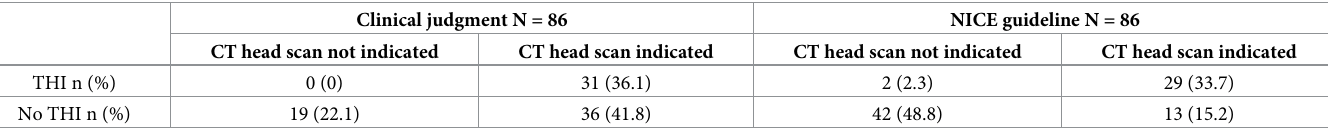
Table 2. Performance of the NICE guideline in comparison to the clinical judgment, n = 86.